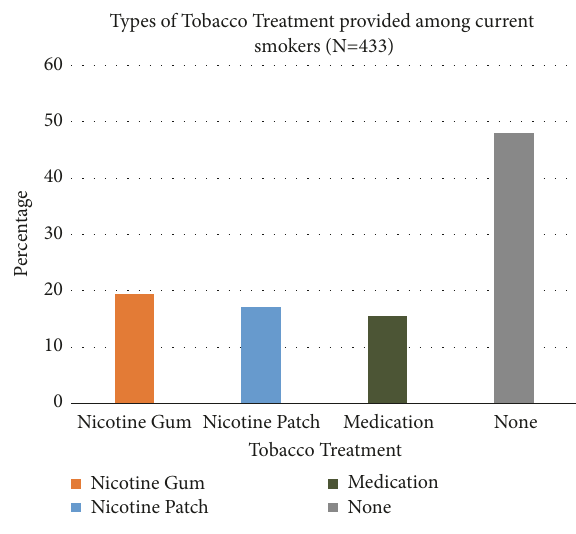
Figure 1: The type of tobacco treatment